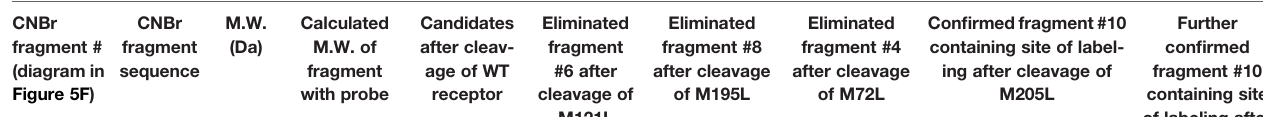
TABLE 2 | Identi fi cation of the receptor CNBr cleavage fragment containing the site of labeling using CCK1R